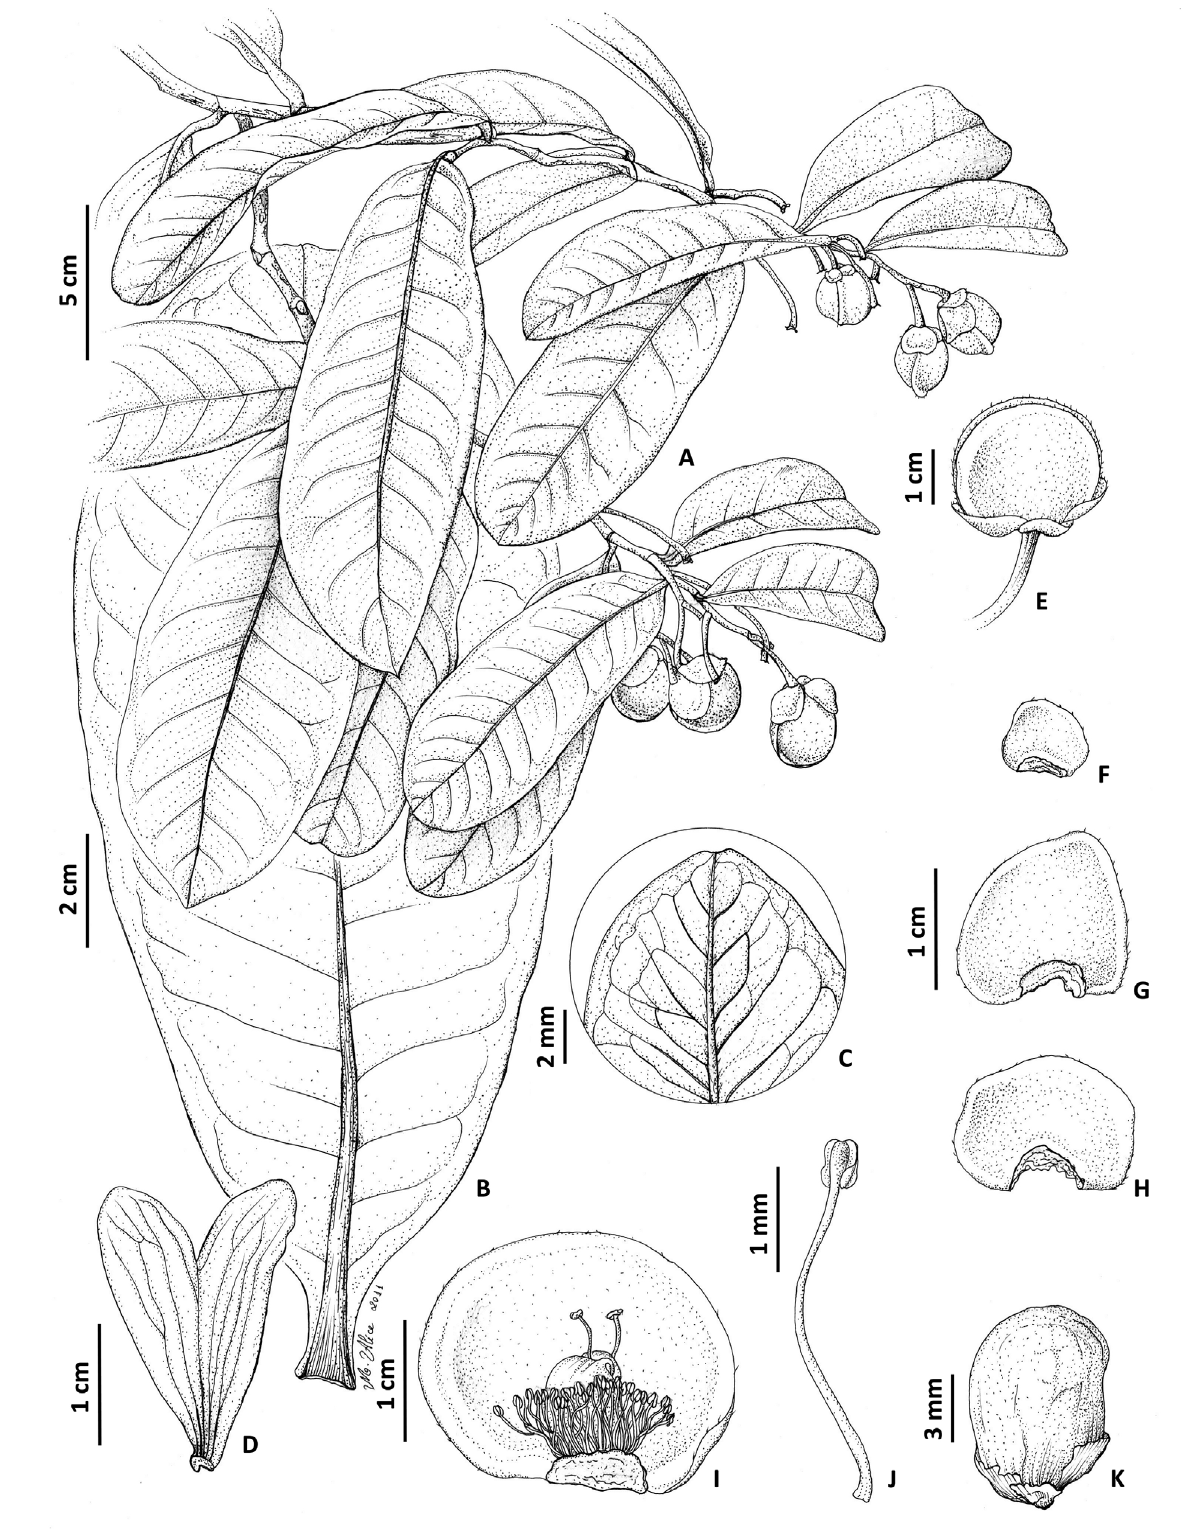
Figure 1 – Davilla coriacea Fraga & Stehmann. A, habit; B, adaxial leaf surface; C, leaf apex, abaxial surface; D, petal, adaxial surface; E, flower in lateral view, showing persistent sepals covering stamens and ovary; F-H, three external sepals, abaxial surface (external, median, and internal); I, frontal view of persistent sepal covering stamens and ovary, with the other internal and all external sepals removed; J, stamen in dorsal view; K, Seed in lateral view, with aril removed. From Fraga et al. 2588 (RB). Drawn by Maria Alice